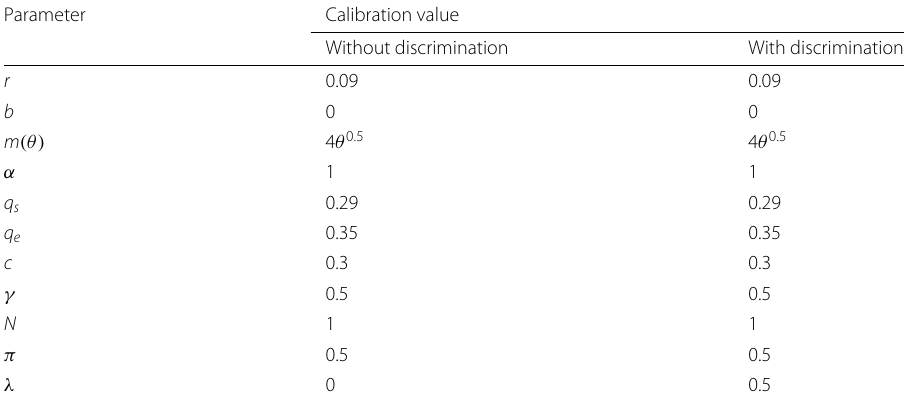
Table 5 Exogenous parameters and functional forms in the baseline model Parameter Calibration value Without discrimination With discrimination